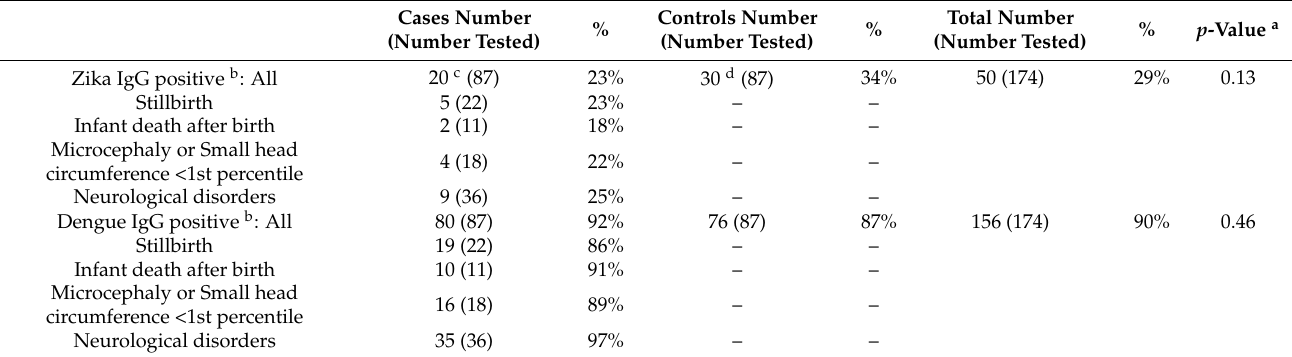
Table 2. Seroprevalence of Zika and dengue IgG among pregnant women with adverse pregnancy outcomes and controls.